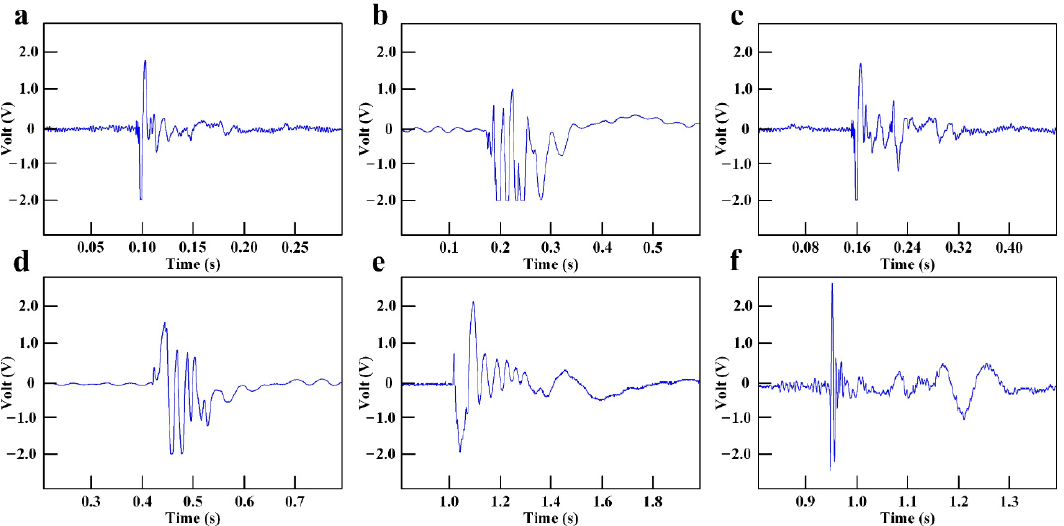
Figure 5. Time-domain signal of electromagnetic radiation measurement experiment under the following conditions: ( a ) Case 1—Lox-Hydrogen; ( b ) Case 2—H2O4-Hydrazine; ( c ) Case 3—AP-HTPB-Al; ( d ) Case 4—Lox-Methane; ( e ) Case 5—Lox-Propane; ( f ) Case 6—Lox-Kerosene.